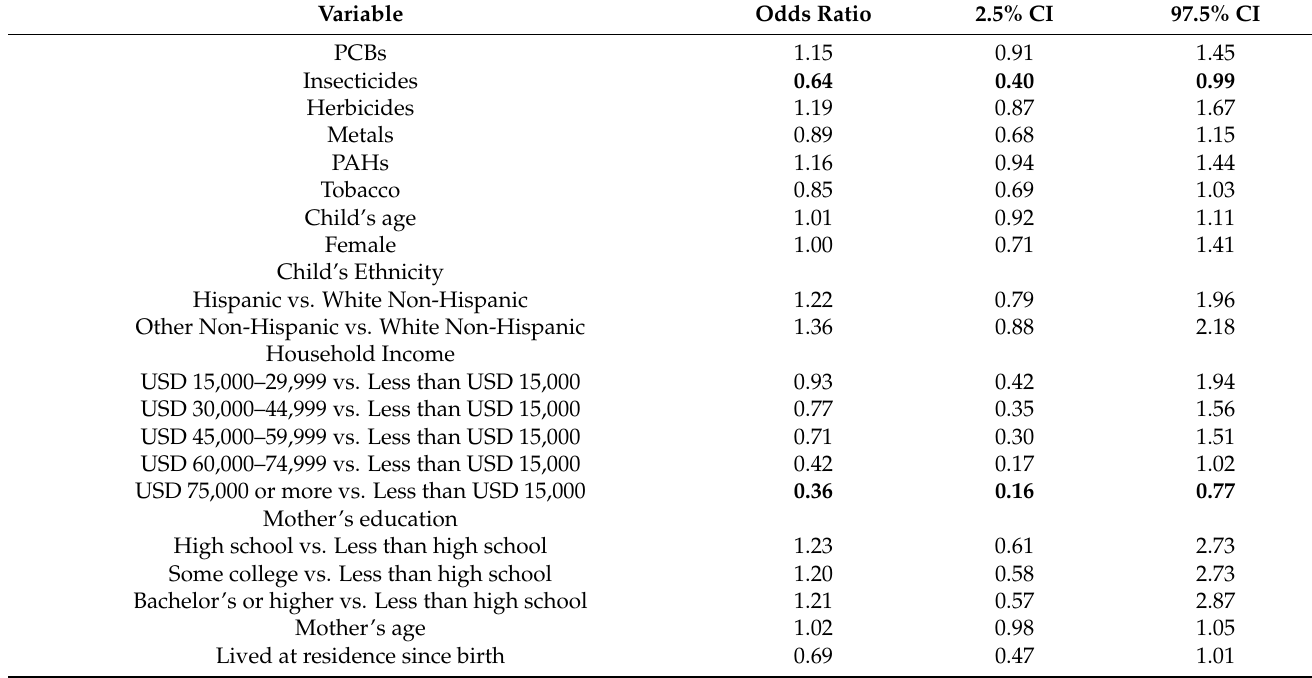
Table 6. Bayesian group index model odds ratios and 95% credible intervals for chemical groups and demographic variables for childhood leukemia in the CCLS. Bold indicates significant effects according to 95% credible intervals. Variable Odds